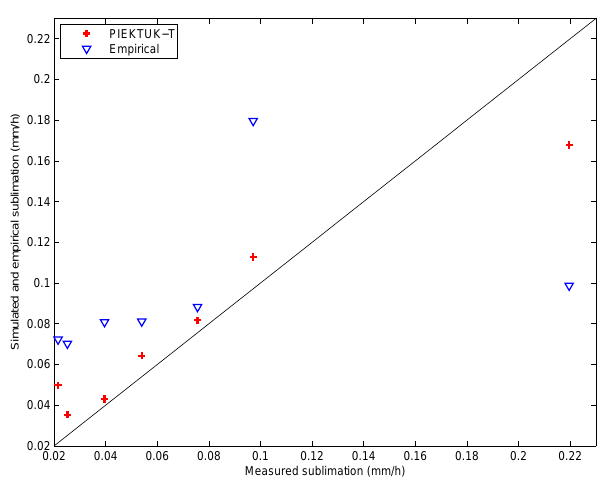
Fig. 13. Comparison of blowing snow sublimation from PIEKTUK-T, the empirical formula, and observation over the Wyoming site. Units in mmh − 1